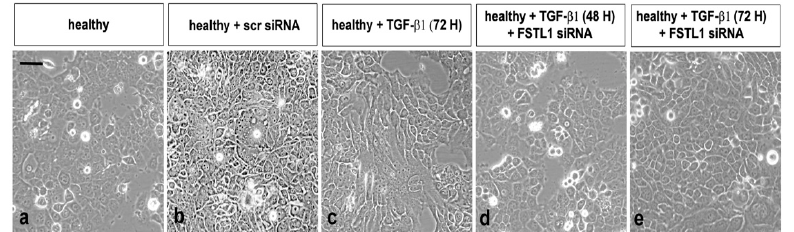
Figure 3. Bright-field micrographs of SGEC treated with TGF- β 1 after FSTL1 gene silencing. SGEC cell morphology was microscopically evaluated. FSTL1 gene knockdown significantly inhibited TGF- β 1-induced morphologic changes in SGEC ( e ). After transfection with FSTL1 siRNA, SGEC show a more epithelial-like morphology in comparison with SGEC treated with TGF- β 1 alone for 48–72 h ( d , e ). ( a ): untreated control cells; ( b ): healthy SGEC transfected with scrambled control siRNA; ( c ): TGF- β 1 treated SGEC for 72 h.